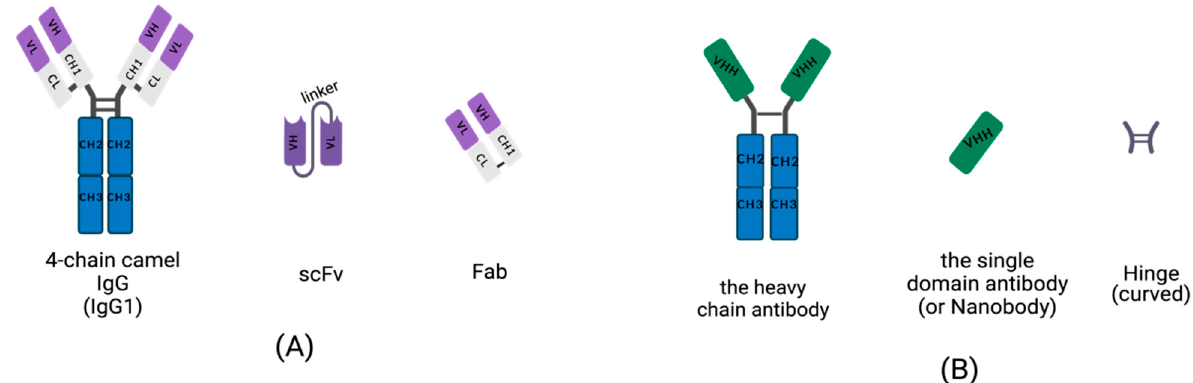
Figure 1. Schematic diagram for the primary structure of a conventional antibody, heavy-chain antibody (HCAb), nanobody, and small, recombinant antibody (This figure was created with BioRender.com, accessed on 27 March 2022). ( A ) A 4-chain camel IgG (IgG1), a class-conventional antibody in mammal serum, which consists of two light chains and two heavy-chains. The single light chain contains a variable region, VL, and a constant region, CL. The single heavy-chain contains a variable region, CL, and three constant regions, CH1, CH2 and CH3. The scFv is composed of a VH and VL pair-linked by an oligopeptide. A Fab fragment is formed by the first two domains of heavy-chain and light chain. ( B ) The single chain of HCAb contains two constant regions, CH2 and CH3 and a variable region, VHH, linked by curved hinge. VHH domain owns the smallest intact antigen-binding fragments, also known as single-domain antibodies (sdAbs) or nanobodies.